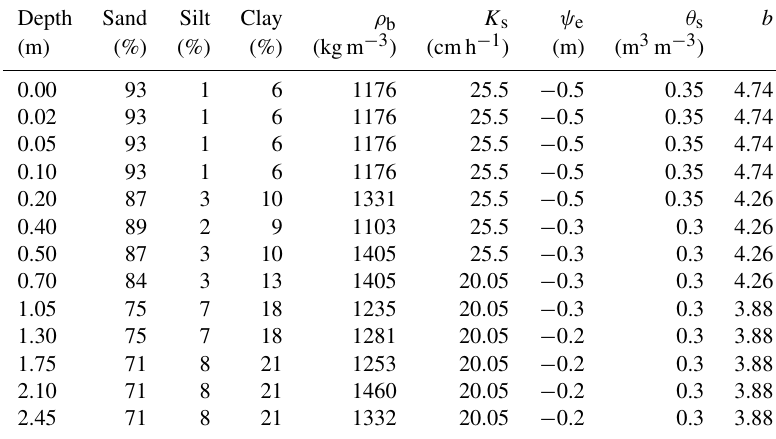
Table 1. Key soil parameter values for the TGL soil profile: ρ b is bulk density; K s is saturated hydraulic conductivity; ψ e is air-entry potential; θ s is saturated volumetric moisture content; and b is pore-size distribution